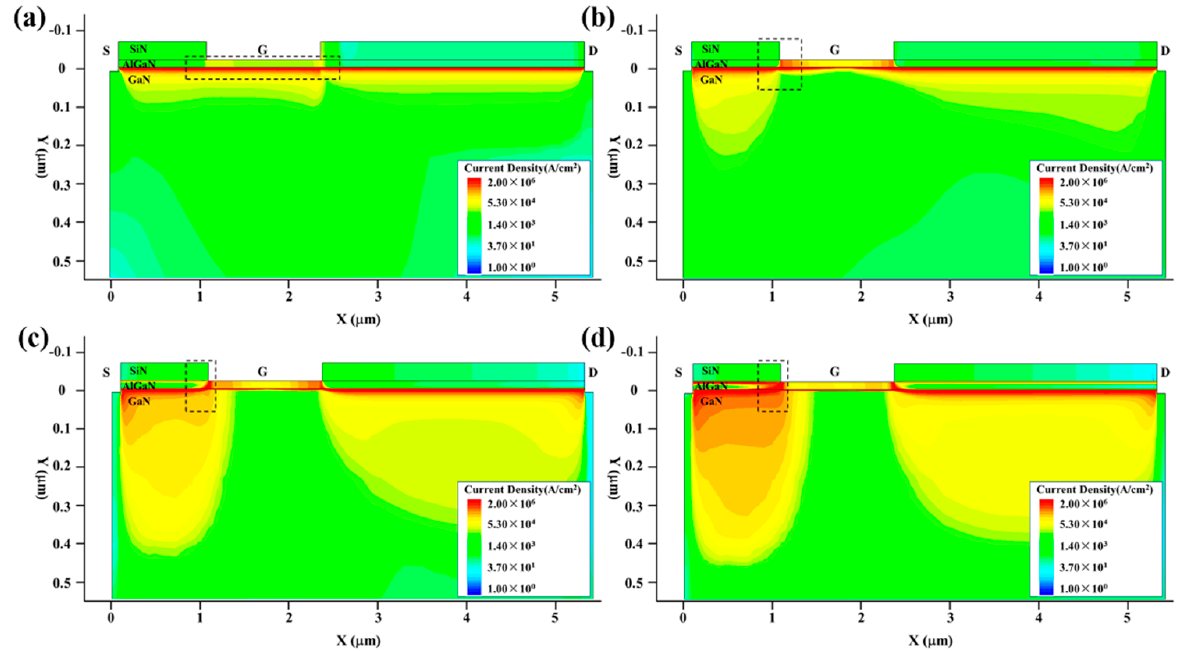
Figure 5. The internal current density distribution of the device at various injection times: ( a ) 0 ns, ( b ) 0.1 ns, ( c ) 0.5 ns and ( d ) 2 ns.